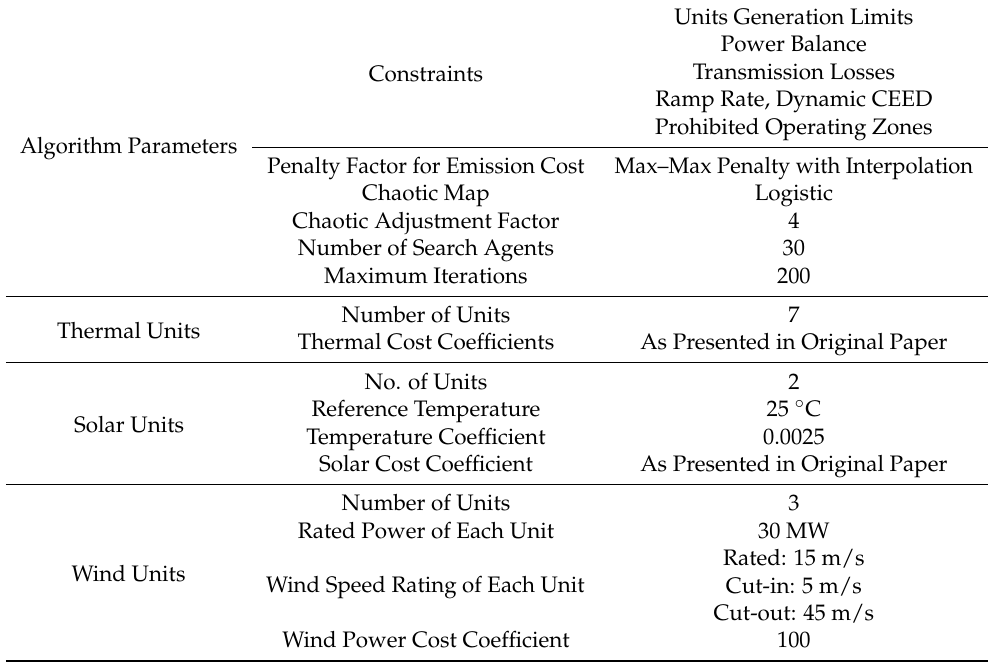
Table 24. Algorithm parameters, constraints, and renewable data—case study 3.